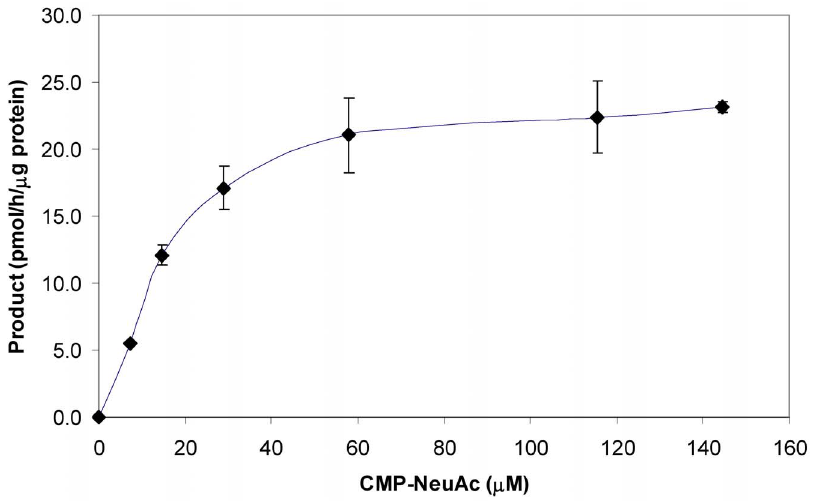
Figure 4. The effect of CMP-NANA concentration on the enzyme activity of rat liver 2,3-sialyltransferase; rat liver 2,3- sialyltransferase (1.4 mU) was incubated with a constant BODIPY-GM1 concentration of 13 m M (1 h incubation, 37 6 C, pH 6) and varying amounts of CMP-NeuAc. Error bars indicate the difference between the high and low values of the duplicate samples.